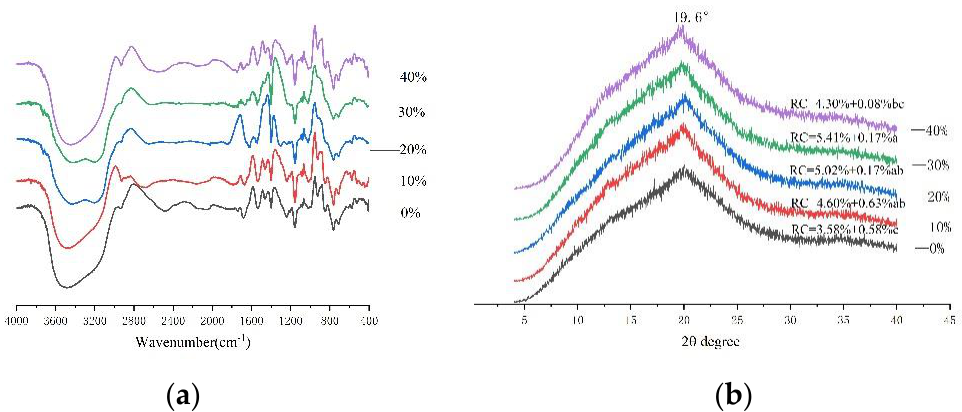
Figure 4. ( a ) FT-IR spectra of noodle doughs. ( b ) XRD spectra of noodle doughs. Different letters within the same group denote significant difference ( p < 0.05).